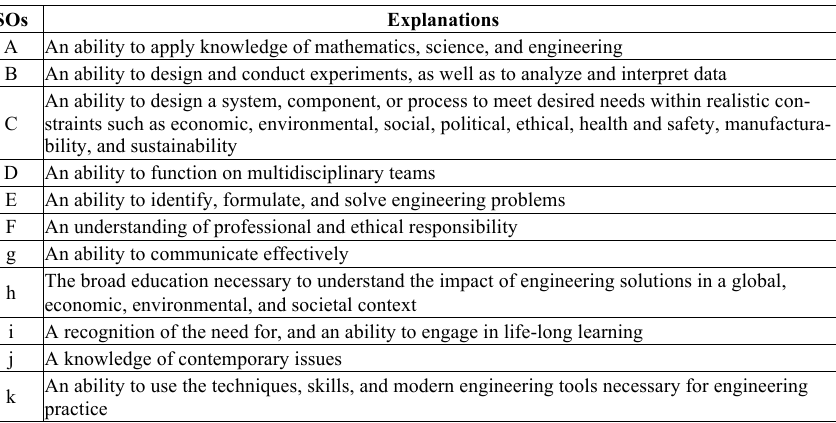
Table 1. Student Outcomes for Engineering